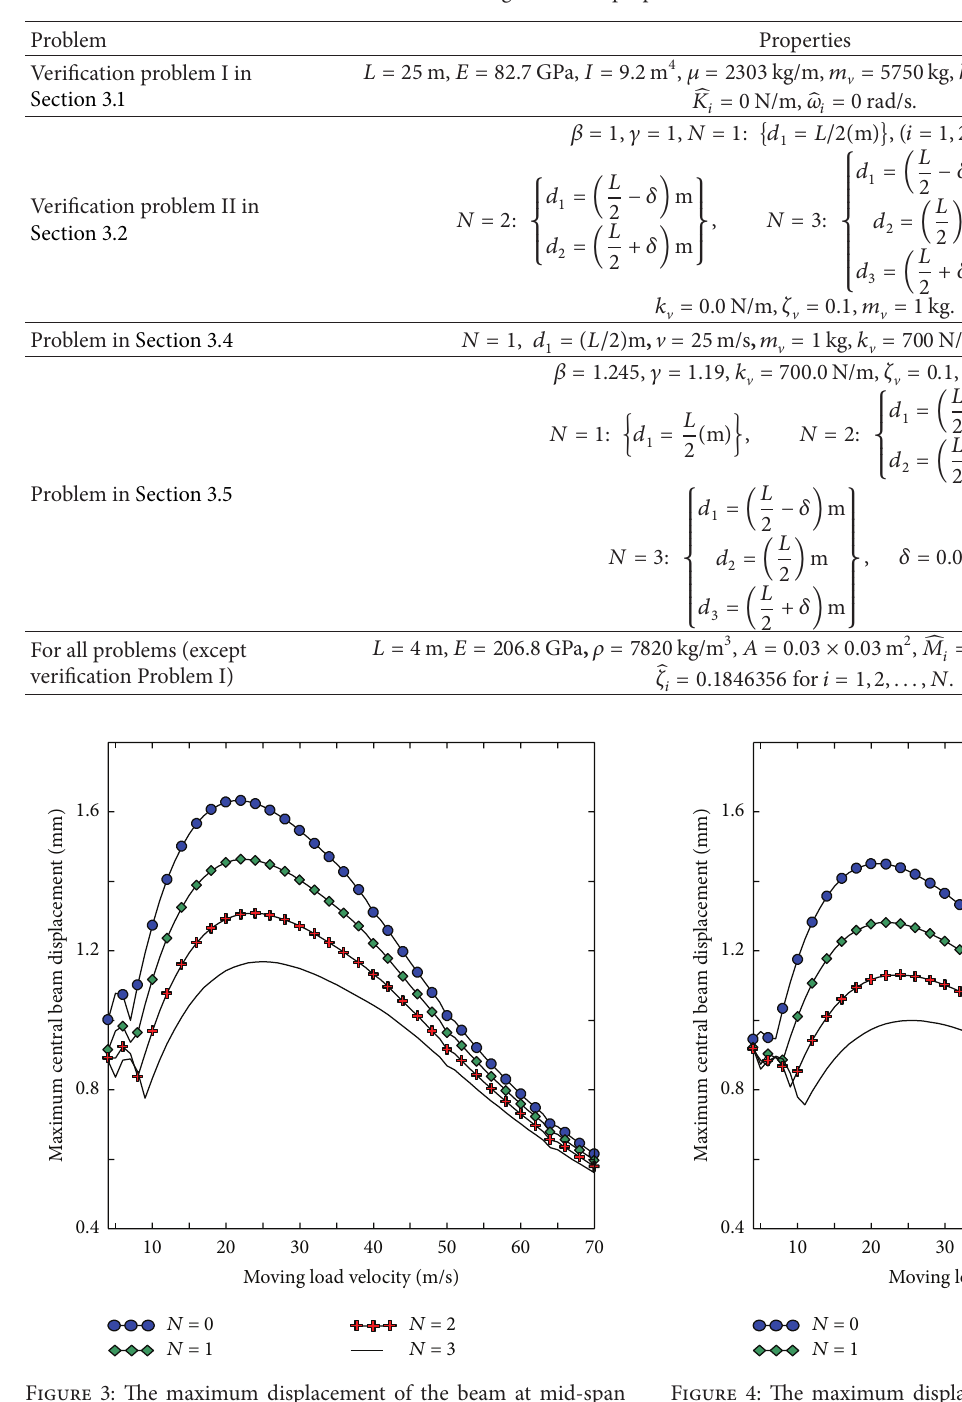
Figure 3: The maximum displacement of the beam at mid-span versus the velocity of the moving load for 𝜁 = 0 .